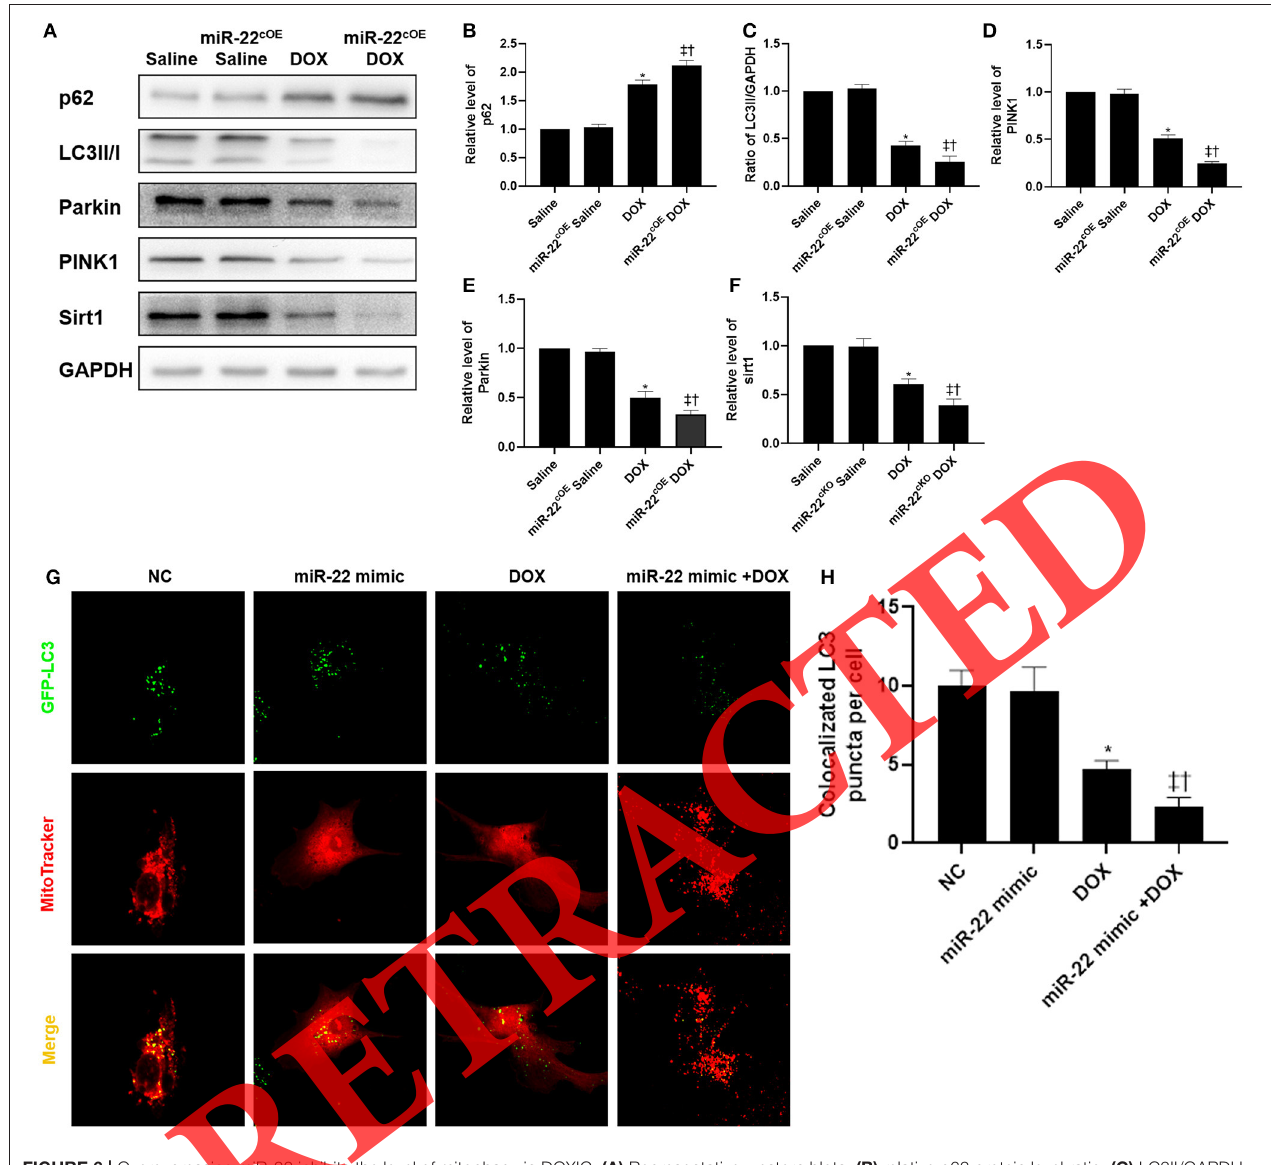
FIGURE 6 | Overexpressing miR-22 inhibits the level of mitophagy in DOXIC. (A) Representative western blots, (B) relative p62 protein level ratio, (C) LC3II/GAPDH ratio, (D) relative PINK1 (PTEN induced putative kinase 1) protein level ratio, (E) relative Parkin protein level ratio, (F) relative sirt1 protein level ratio, Data were expressed as mean ± SEM. * P < 0.05 vs. saline group, ‡ P < 0.05 vs. DOX group, † P < 0.05 vs. miR-22 cOE group. (G) Representative colocalization images of GFP-LC3 (green) and mitochondria (MitoTracker red), (H) Quantitative analysis of GFP-LC3 puncta per cell. Scale bars = 2 µ m. * P < 0.05 vs. NC group, ‡ P < 0.05 vs. NC + DOX group, † P < 0.05 vs. miR-22 mimic group. All the experiments were repeated three